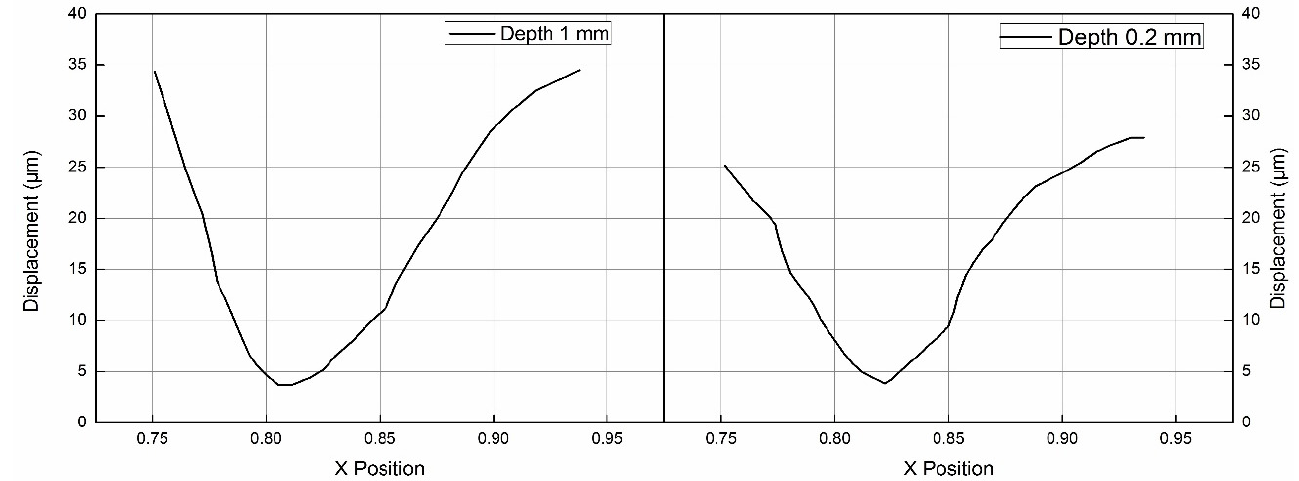
Figure 5. Output signals corresponding to slot defects of different depths.